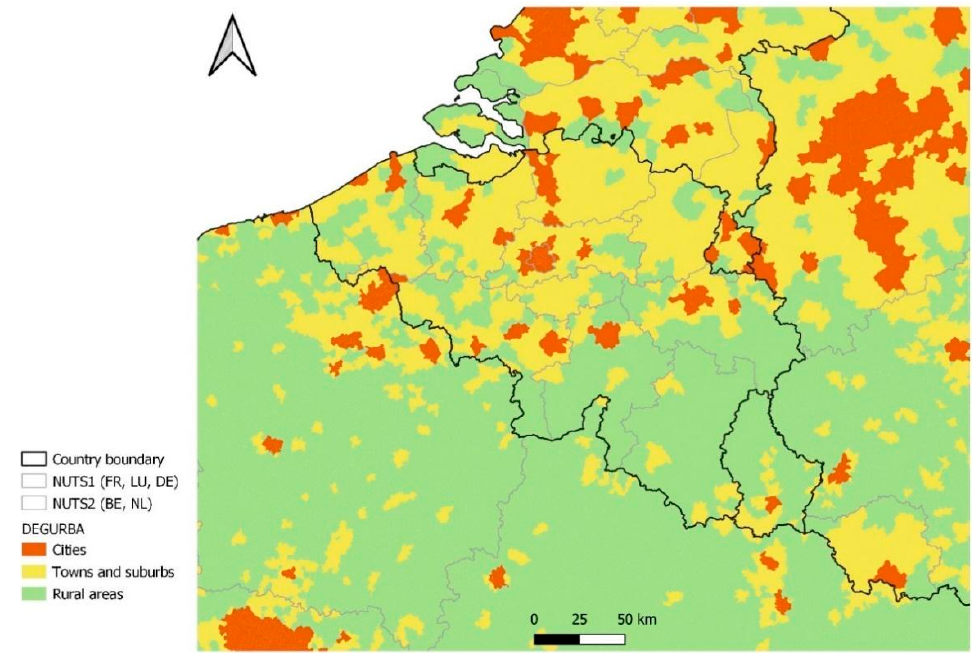
Figure 2. Degree of urbanization in Belgium and the neighboring countries.